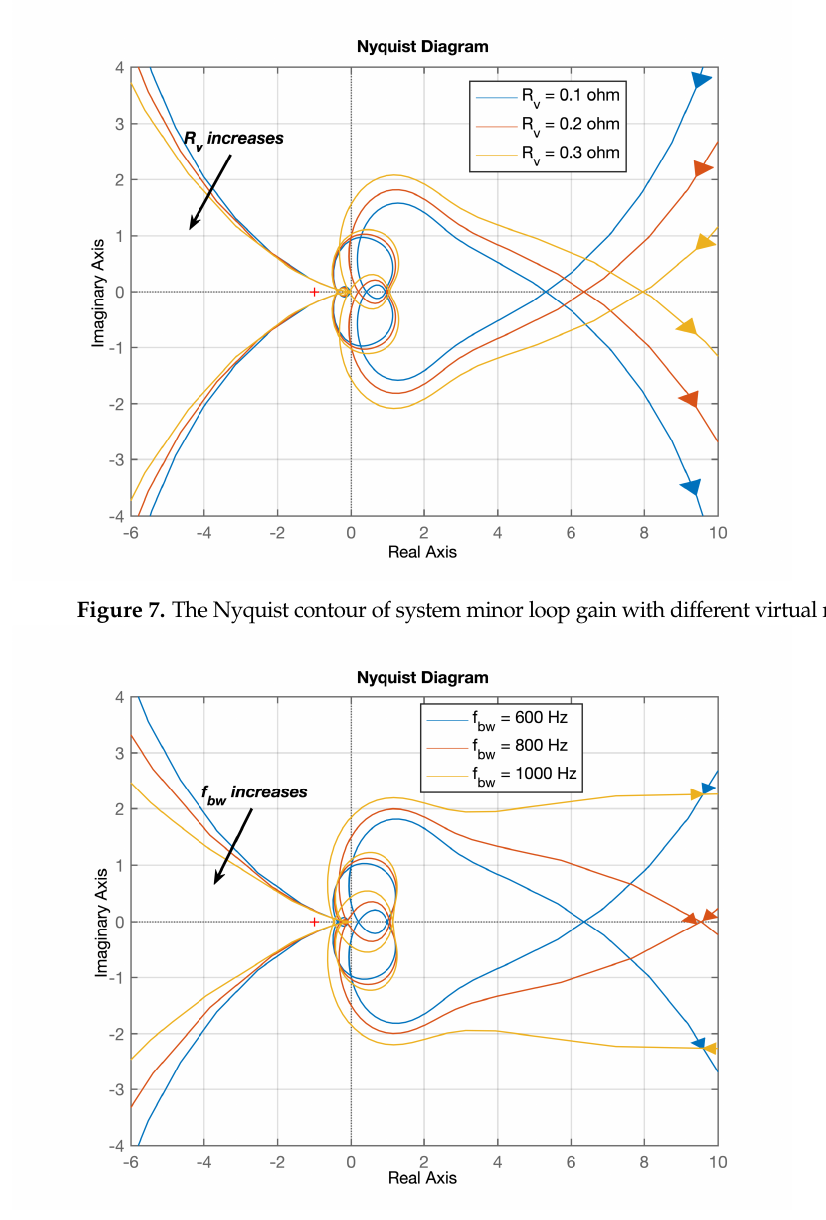
Figure 8. The Nyquist contour of system minor loop gain with different bandwidth of current controller at rated power with R v equal to 0.2